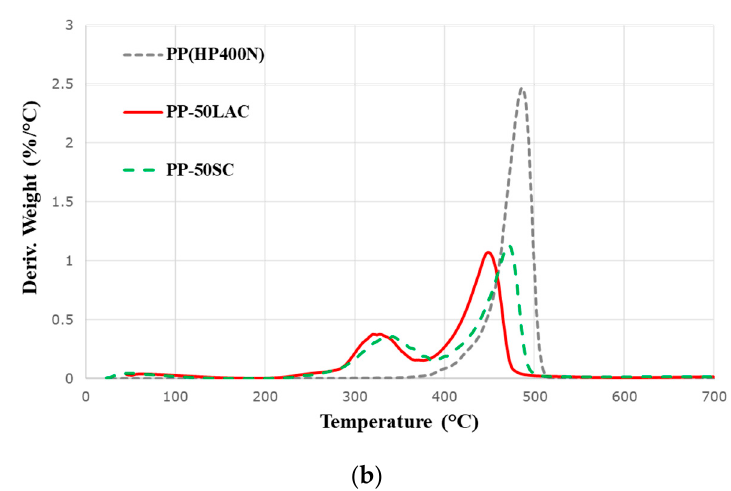
Figure 4. ( a ) Thermogravimetric and ( b ) derivative thermogravimetric curves of neat PP and PP–casein (LAC/SC) samples in nitrogen.